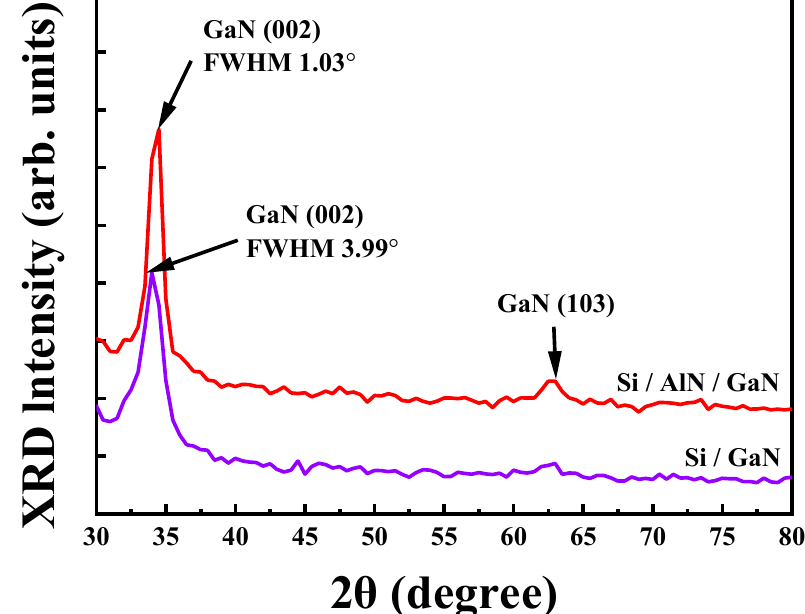
Figure 8. XRD patterns for Si/GaN and Si/AlN/GaN thin films. XRD pole figures for the Si/AlN/GaN thin film structure are shown in Figure 9. The values corresponding to the GaN (002) and (103) at 34.3° and 62.6°, respectively, were used for the analysis, with the values of phi ( Ψ ) 0–360° and chi ( χ ) 0–75° for the measurement. The randomly oriented patterns from the pole figures for both GaN (002) and (103) suggest that the films are of polycrystalline nature. Since distinctive symmetric spots suggest the formation of crystalline orientation, further optimizations are needed on the stacking structure to improve the crystalline quality of the films [55,56]. Figure 9. Pole figures for (002) and (103) Si/AlN/GaN stacked thin film structure. Figure 10 presents the PL spectra of Si/GaN and Si/AlN/GaN thin-film structures ob- tained with a He–Cd laser at a wavelength of 325 nm, excitation power of 30 mW, and measurement temperature of 10 K. In the measurement, a 0.5-meter monochromator (iHR 550) was used to measure the signal using a cooled charge-coupled device. PL spectros- copy was used to investigate the energy bands, impurities, energy transitions, crystal quality, and defect types of the GaN samples. The near-band-edge emission (NBE; 365 nm) of the GaN thin films deposited through sputtering was investigated; the near-band- edge emission is critical for developing high-quality GaN films for different applications. The main peaks for Si/AlN/GaN and Si/GaN samples were observed at 3.37 and 3.36 eV, respectively. The peak at 3.3 eV generally corresponds to NBE in GaN thin films, which crystallize with a hexagonal structure. It can also be ascribed to the recombination of ex- citons bound to neutral donors [57]. The PL FWHM for Si/GaN was 29.1 meV, and that